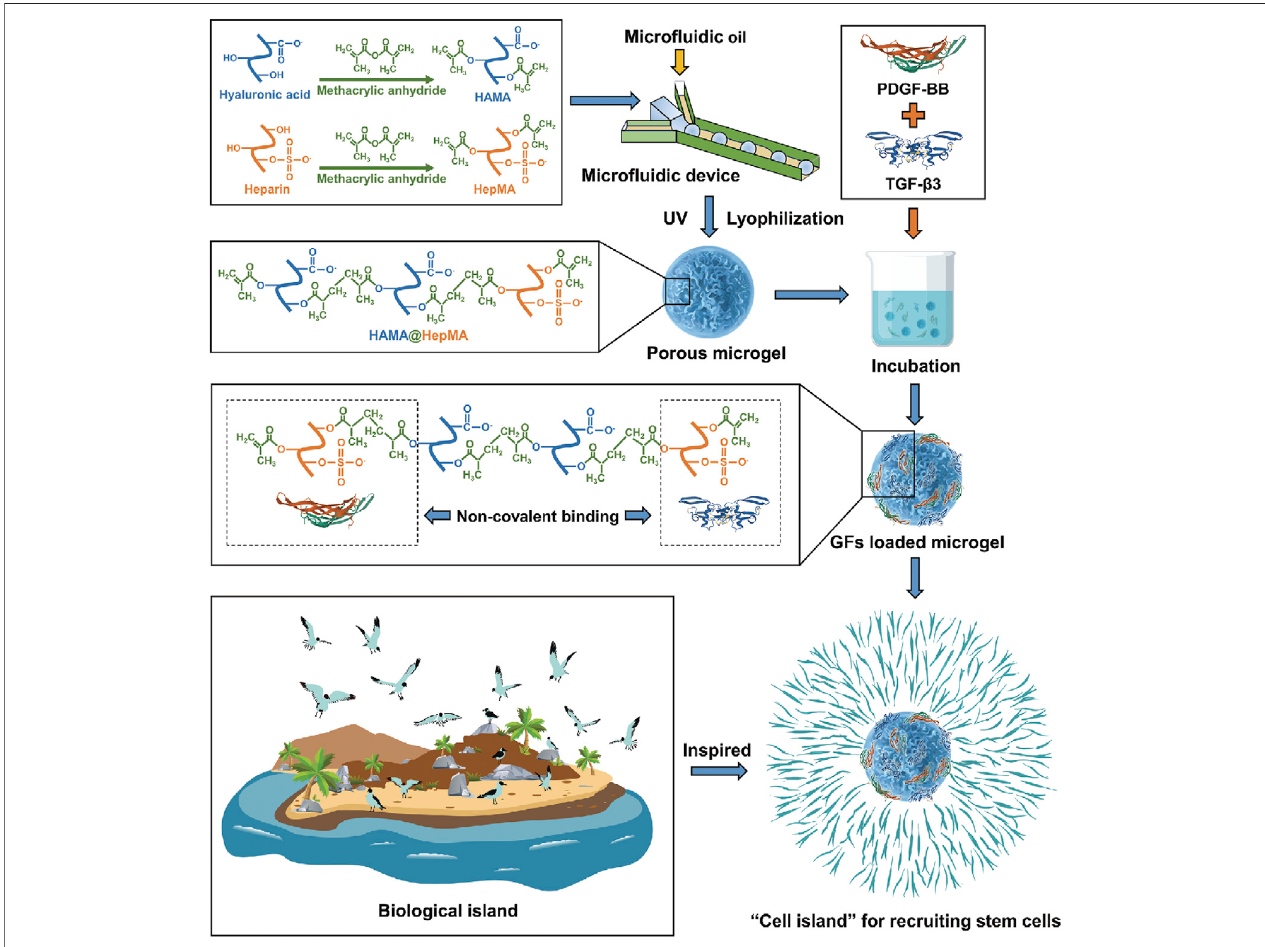
FIGURE 5 | Illustration of the fabrication of “ cell island ” microgels. The injectable porous microgel was fabricated by photopolymerization of methacrylated hyaluronic acid and heparin (HAMA@HepMA) blend pregel droplets generated via micro fl uidic technology. Subsequently, PDGF-BB and TGF- β 3 were non-covalently incorporated within the microgels by binding heparin, forming “ cell island ” microgels that can directly recruit stem cells post injection. Reproduced with permission from Lei Y. et al., Adv Funct Mater ; published by Wiley-VCH, 2021.